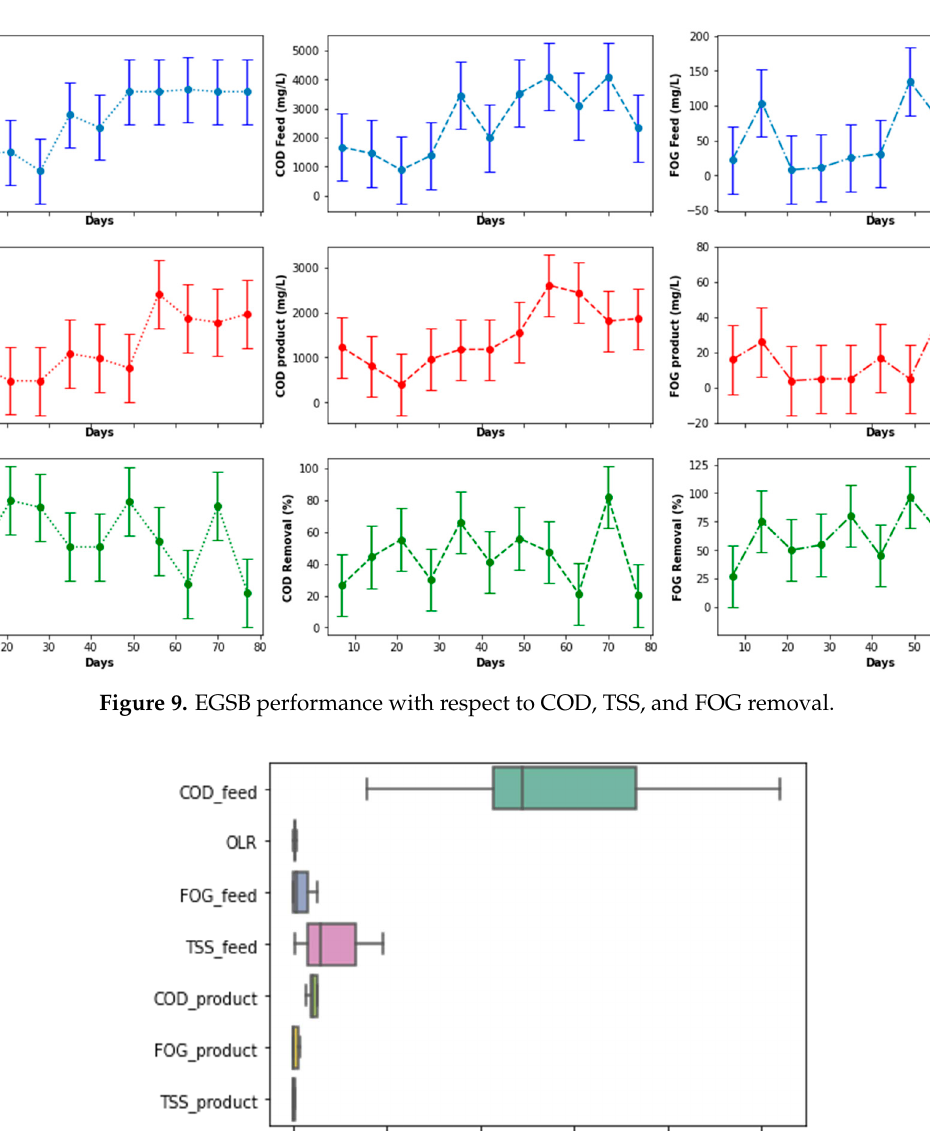
Figure 10. Boxplot of the EGSB parameters.